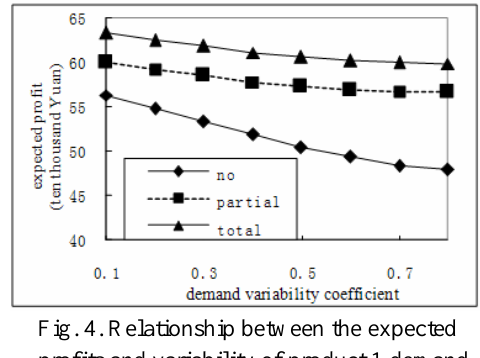
Fig. 4. Relationship between the expected profits and variability of product 1 demand